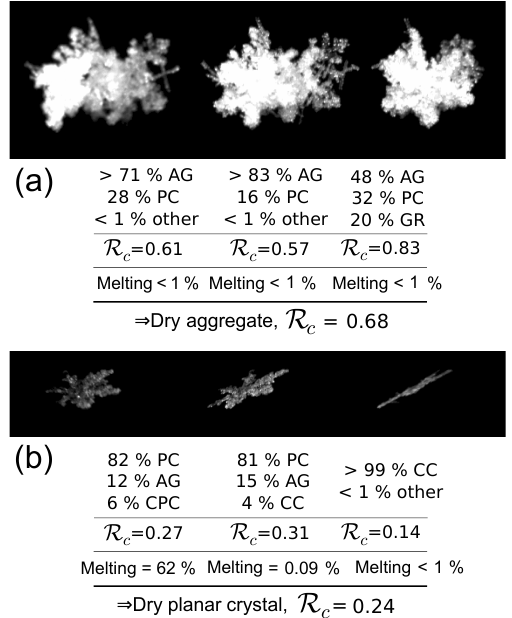
Figure 12. Illustration of the prediction merging process applied on two unlabeled MASC image triplets. (a) A dry, heavily rimed aggregate. (b) A dry, moderately rimed planar